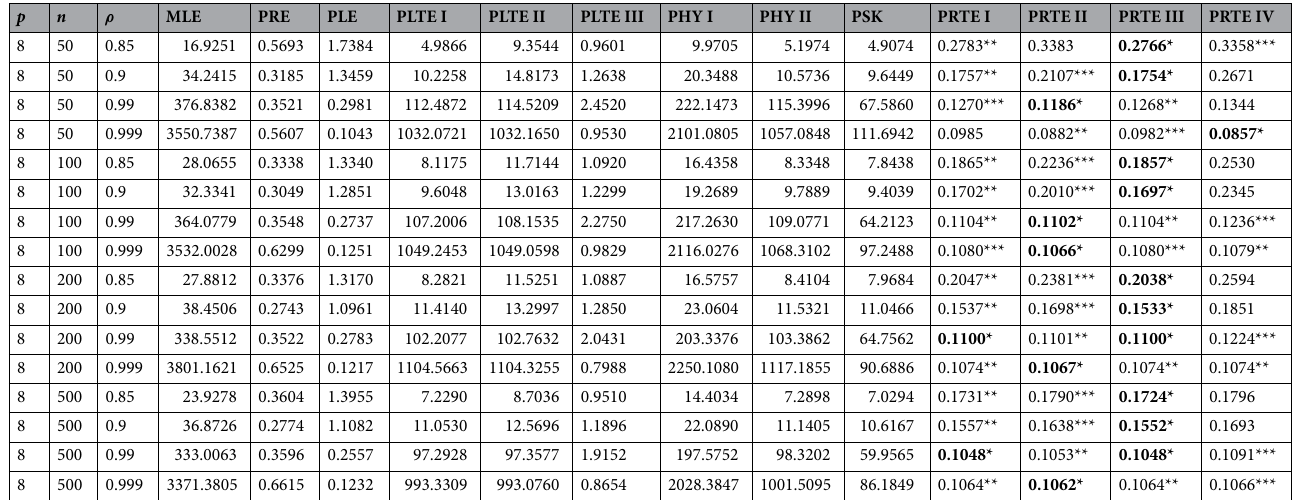
Table 3. The EMSE values of the estimators when p = 8.